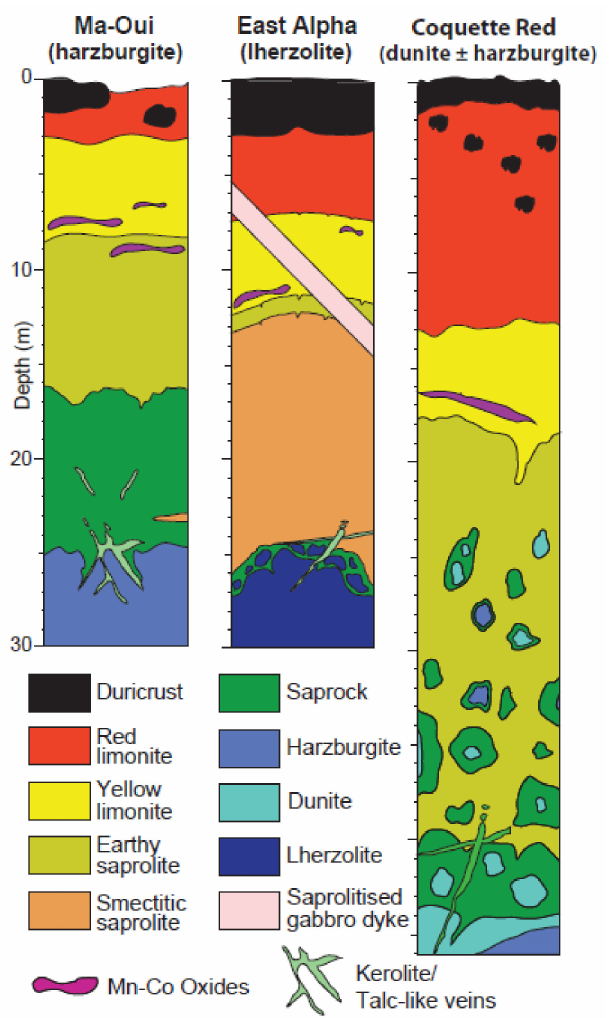
Figure 4. Stratigraphic logs of representative Ni-Co laterites from the Ma-Oui deposit, Coquette Red tenement, and East Alpha deposit. Modified after